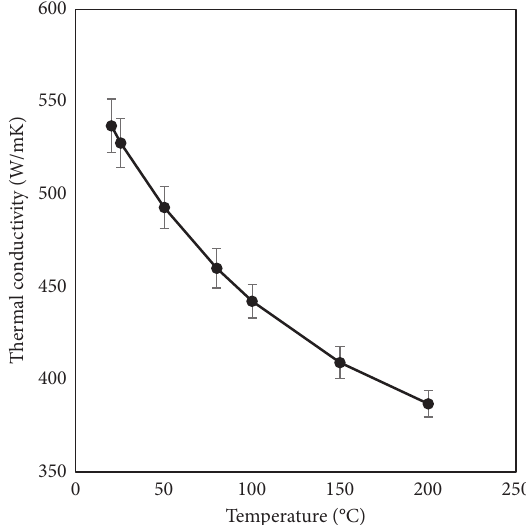
Figure 6: Thermal conductivity of CuCD RHP3434.